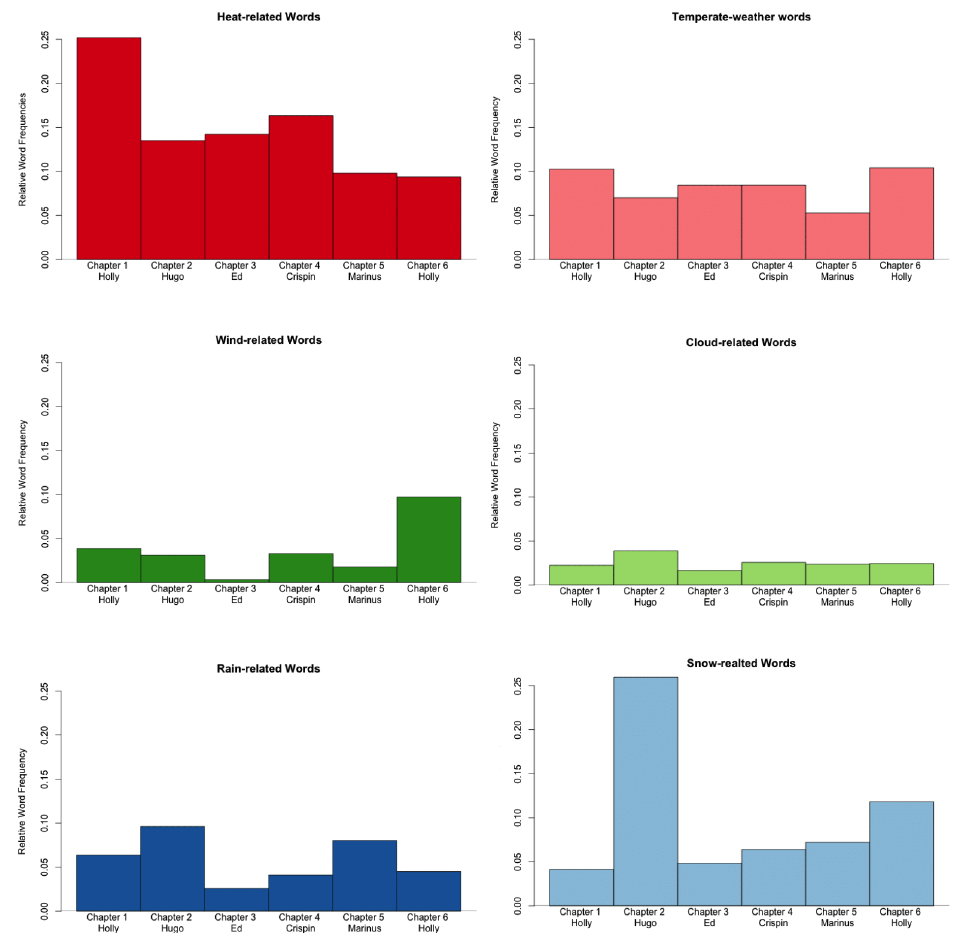
Figure 2. A comparison of the relative frequency of words associated with different types of weather across the six chapters in The Bone Clocks . The first and last graphs show that Chapter 1 is the hottest chapter, while Chapter 2 is the snowiest chapter respectively. The third graph shows that wind will make an appearance in the final chapter. While weather is present throughout the novel, heat and snow comprise the most extreme weather events. The temperate weather, clouds, and rain are less memorable. The final chapter turns wind into another example of extreme weather due to possible windborne